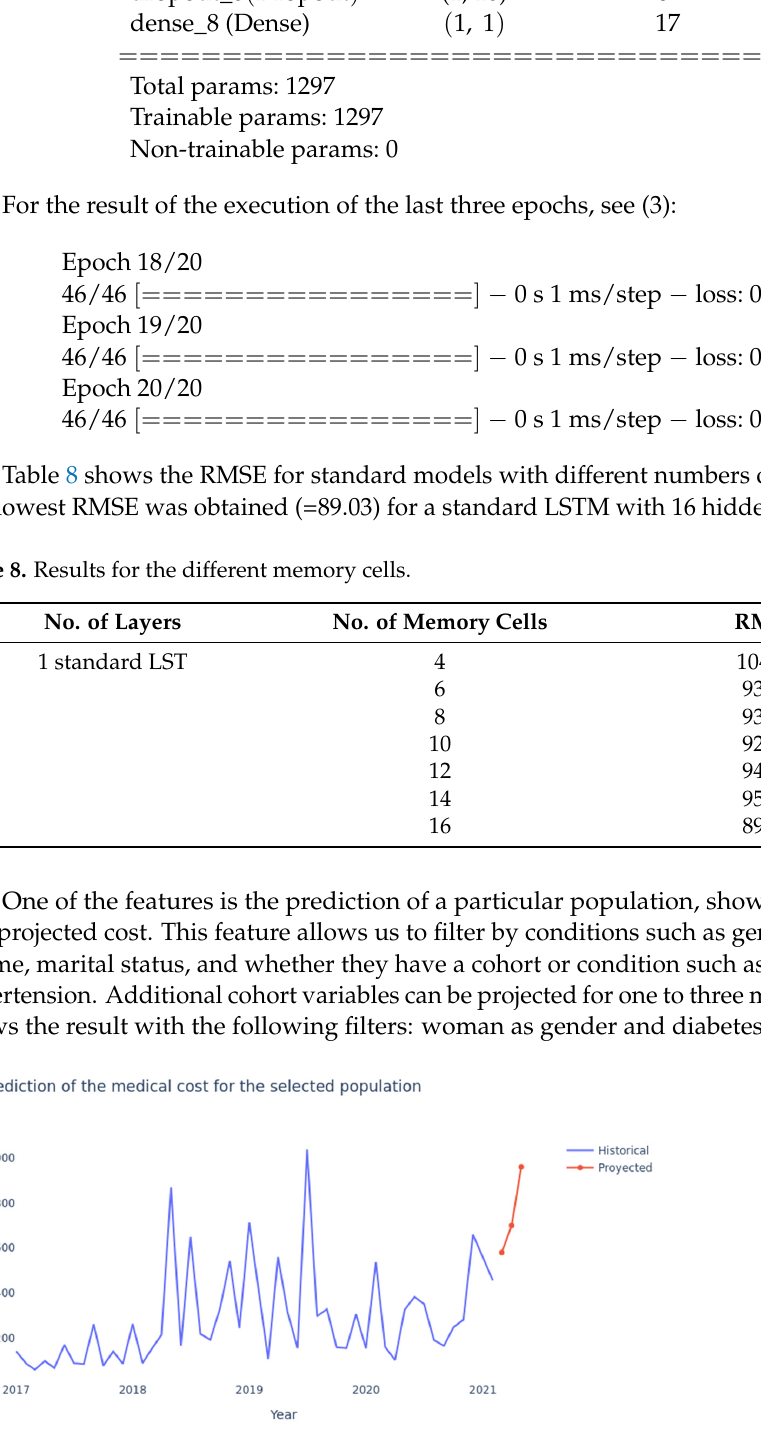
Figure 6. Projected cost using the LSTM